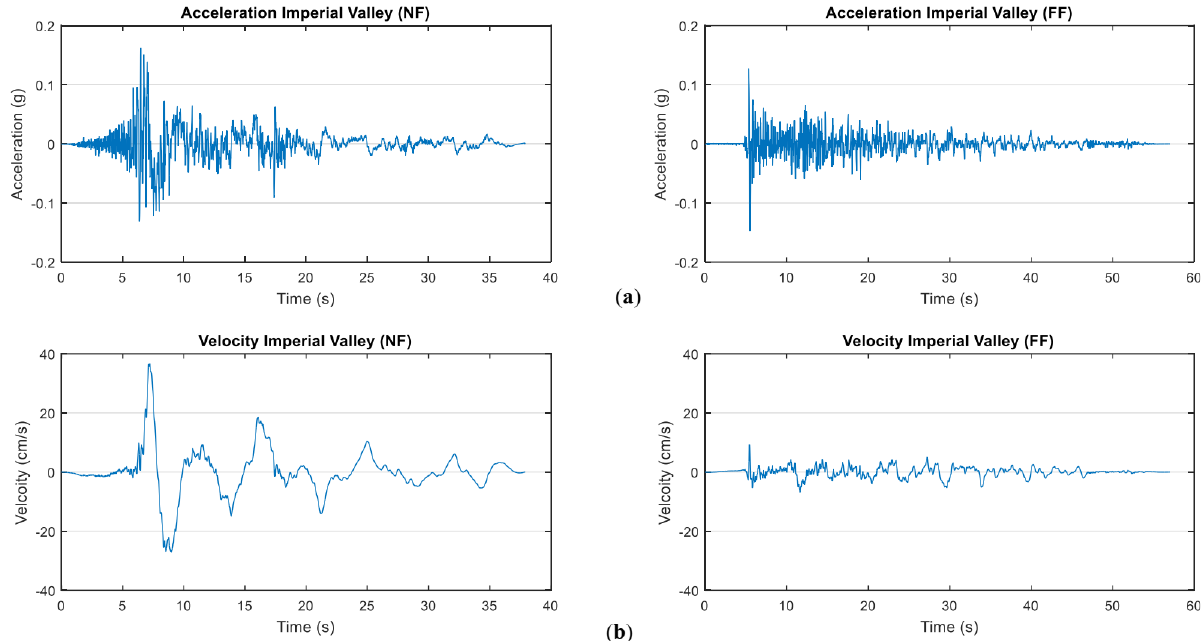
Figure 4. Near-fault and far-fault ground motions recorded at the Imperial Valley earthquake in 1979. ( a ) Acceleration time histories for near-fault and far-fault earthquake records. ( b ) Velocity time-histories for near-fault and far-fault earthquake records